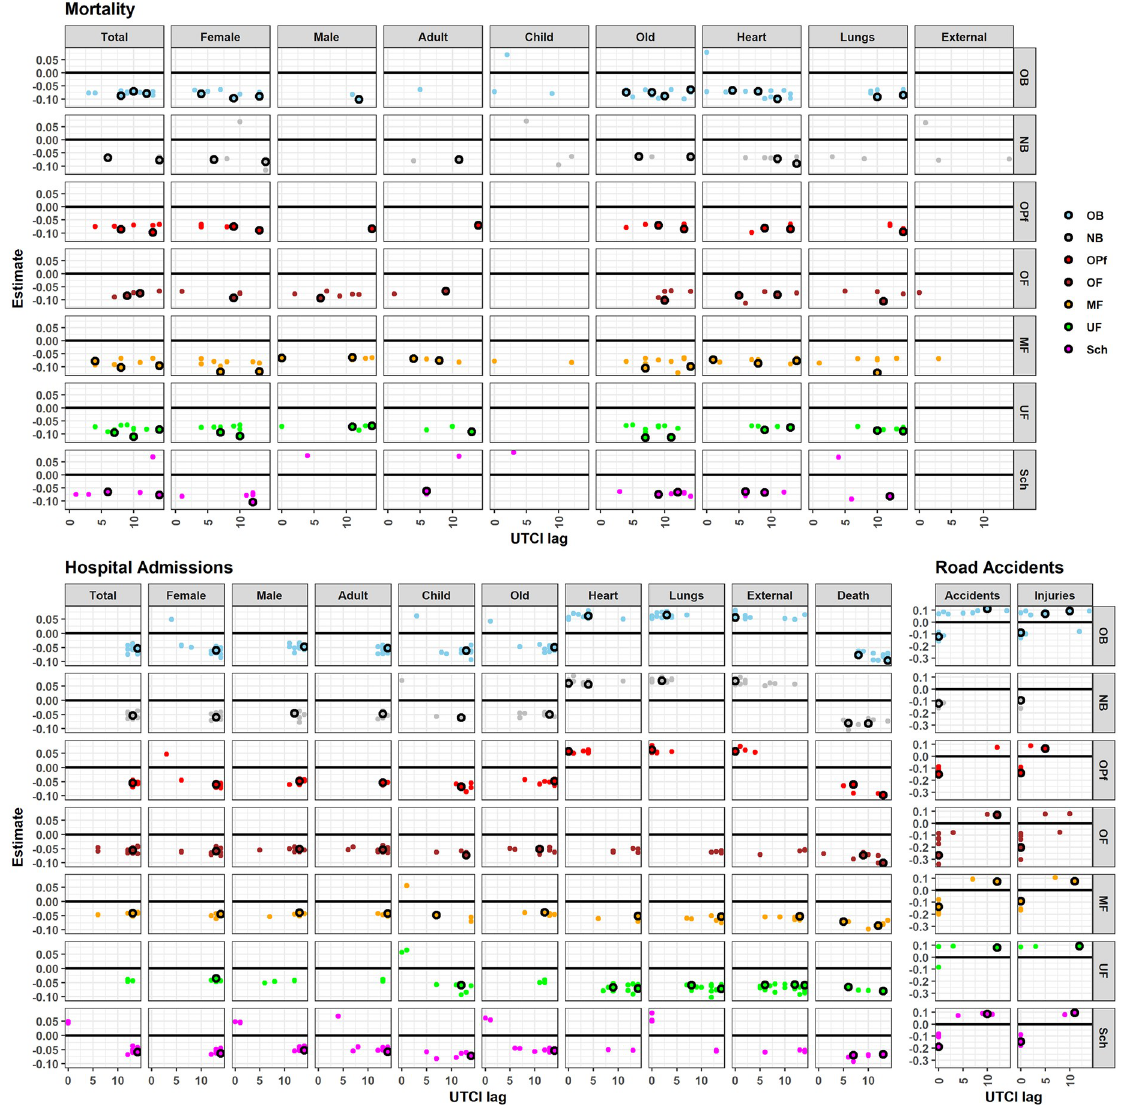
Fig 4. Winter UTCI effect. Winter UTCI effect on daily cases of mortality, hospital admissions, and road accidents for each subgroup and district. The horizontal axis represents the lag in days, and the vertical axis represents the effect estimate. It is expressed in proportion of the standard deviations of daily number of cases within the corresponding subgroup when UTCI changes by one standard deviation of its daily value. The black circles represent those effects for each region. The colored dots represent those effects for districts within the region. The absence of points indicates that the effect of UTCI was not significant for a particular lag in the corresponding model.